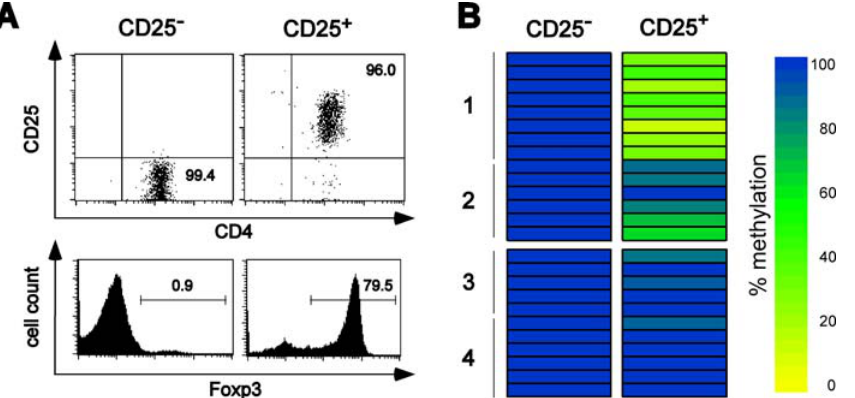
Figure 5. Demethylated CpG Motifs within the foxp3 Locus in CD25 þ CD4 SP Thymocytes (A) CD25 þ CD4 þ CD8 (cid:1) and CD25 (cid:1) CD4 þ CD8 (cid:1) subsets were sorted from thymocytes pooled from 30 male BALB/c mice. FACS analysis shows purity of sorted subsets (upper panel) and Foxp3 expression in gated CD25 (cid:1) and CD25 þ subsets of CD4 þ SP thymocytes (lower panel). Numbers display frequency of cells within indicated populations. The bars in the lower graphs indicate the marker gate for Foxp3 þ cells. The vertical and horizontal lines in the upper graphs indicate the quadrant used to identify the CD4 þ CD25 þ / (cid:1) subsets. (B) Methylation pattern of selected amplicons of the foxp3 locus in CD25 þ and CD25 (cid:1) CD4 SP thymocytes. The methylation status of individual CpG motifs within the four amplicons is color coded as described in Figure 2. One representative experiment out of two individual experiments is